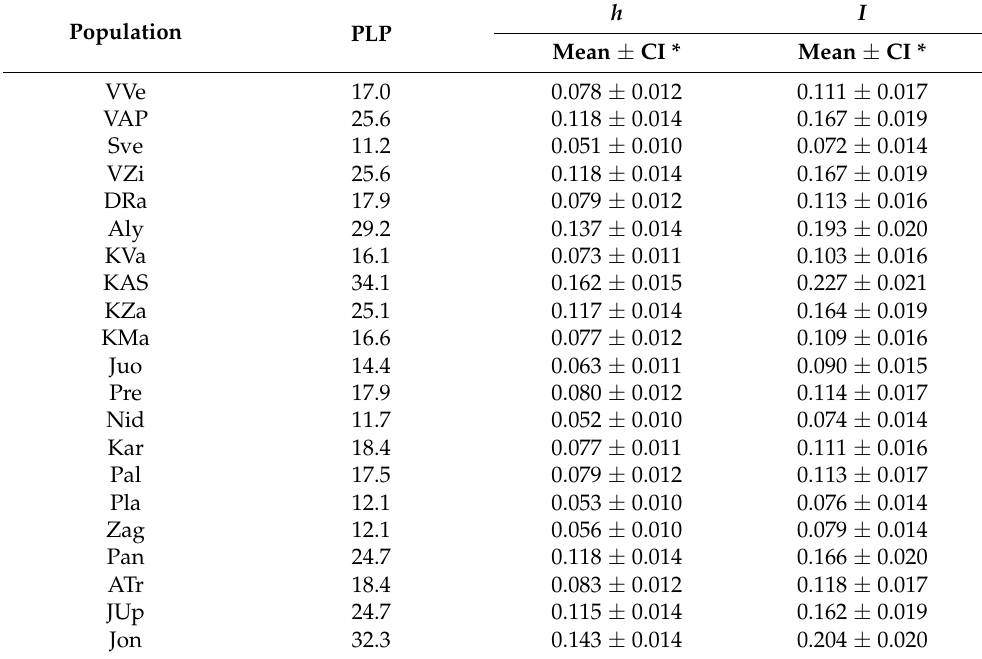
Table 2. The indices of genetic diversity for small balsam ( Impatiens parviflora ) populations using AFLP